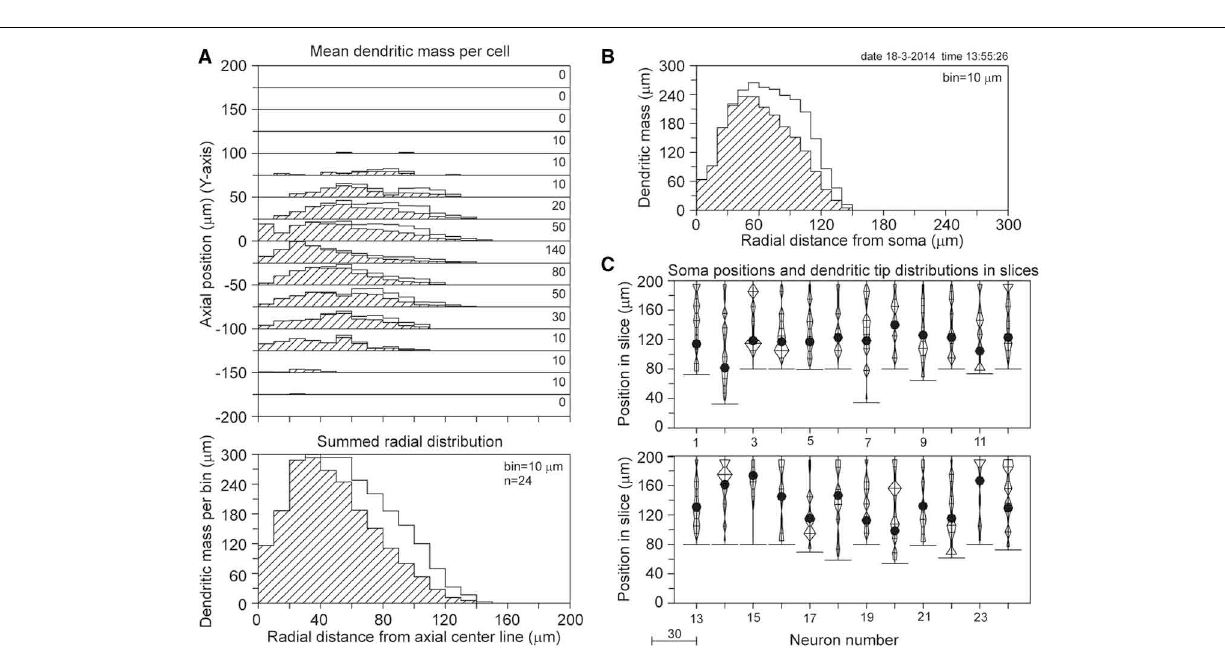
soma positions in the slices, we aligned the neurons at the side with an accumulation of cut endings as shown in (C) . Because for some neurons the Z-range was larger than 120 μ m, the Z-range in the panel was set at 200 μ m with the neurons aligned at their cut endings at the top of the